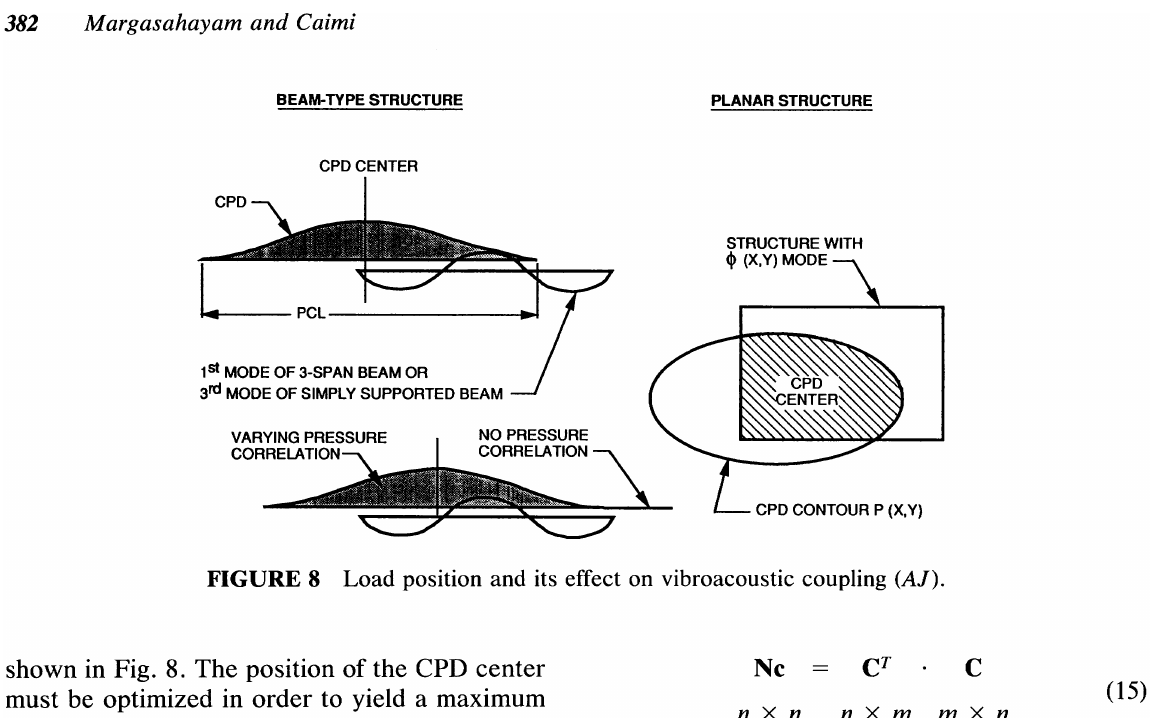
FIGURE 8 Load position and its effect on vibroacoustic coupling